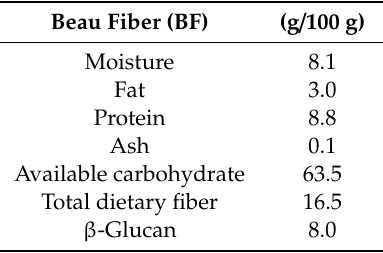
Table 1. Nutritional components of Beau fiber